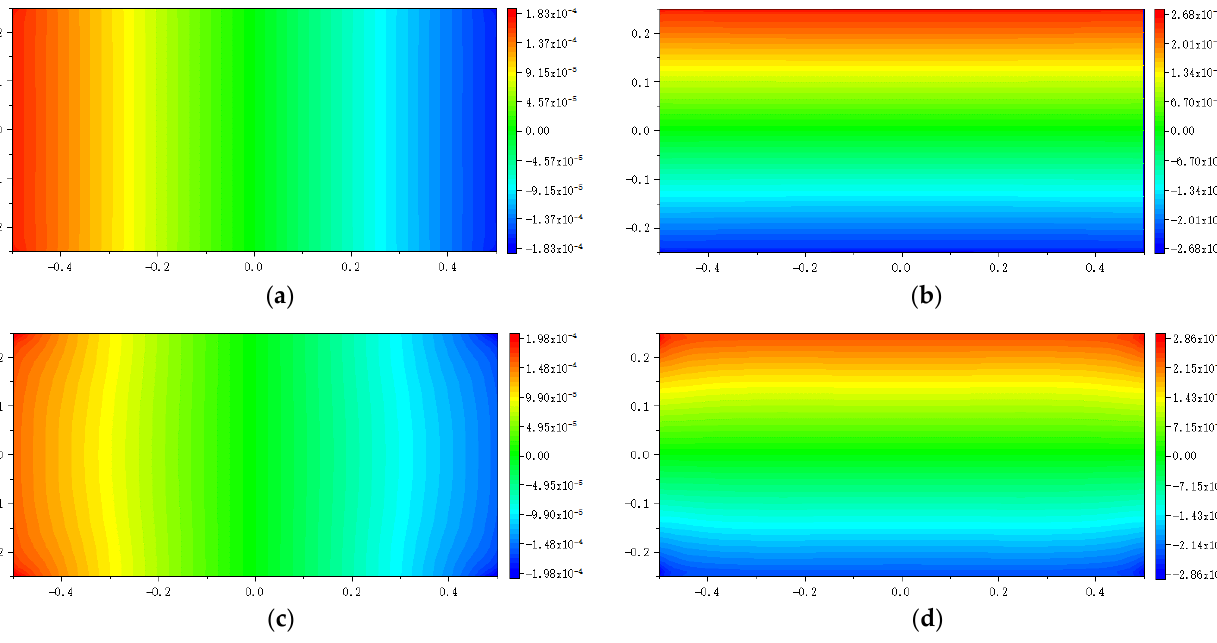
Figure 10. The distribution of displacement in the rectangular plate subjected to tension: ( a ) u x calculated by original PD; ( b ) u y calculated by original PD; ( c ) u x calculated by Equation (7); ( d ) u y calculated by Equation (7).